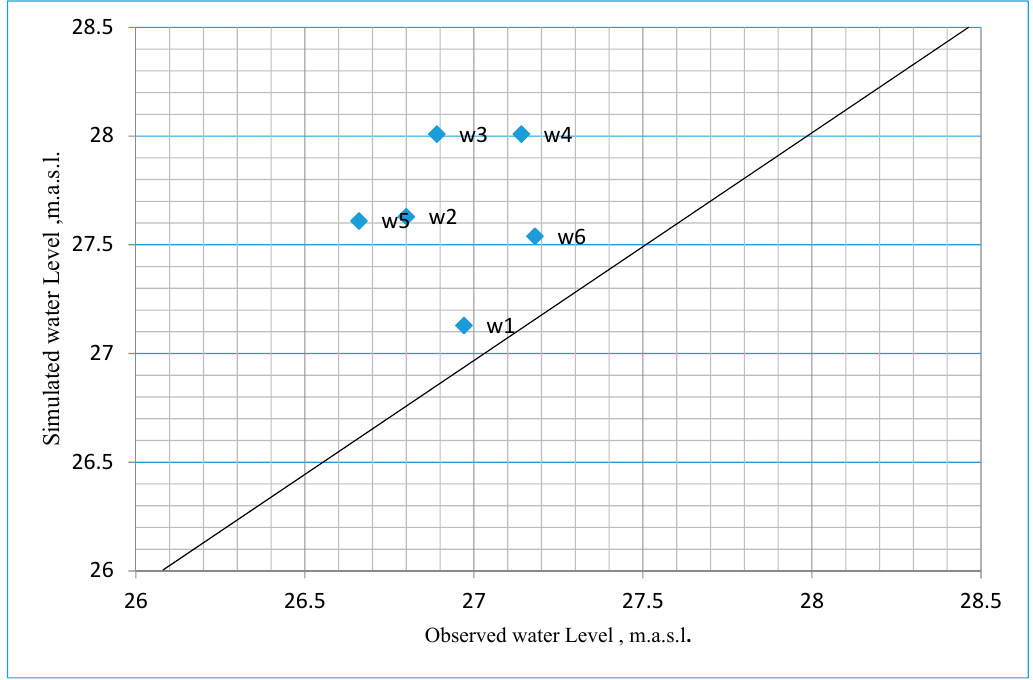
Figure 9. Comparison of simulated and observed heads for average water surface elevation of Tigris River (29.20 m.a.s.l.), Scenario 1.